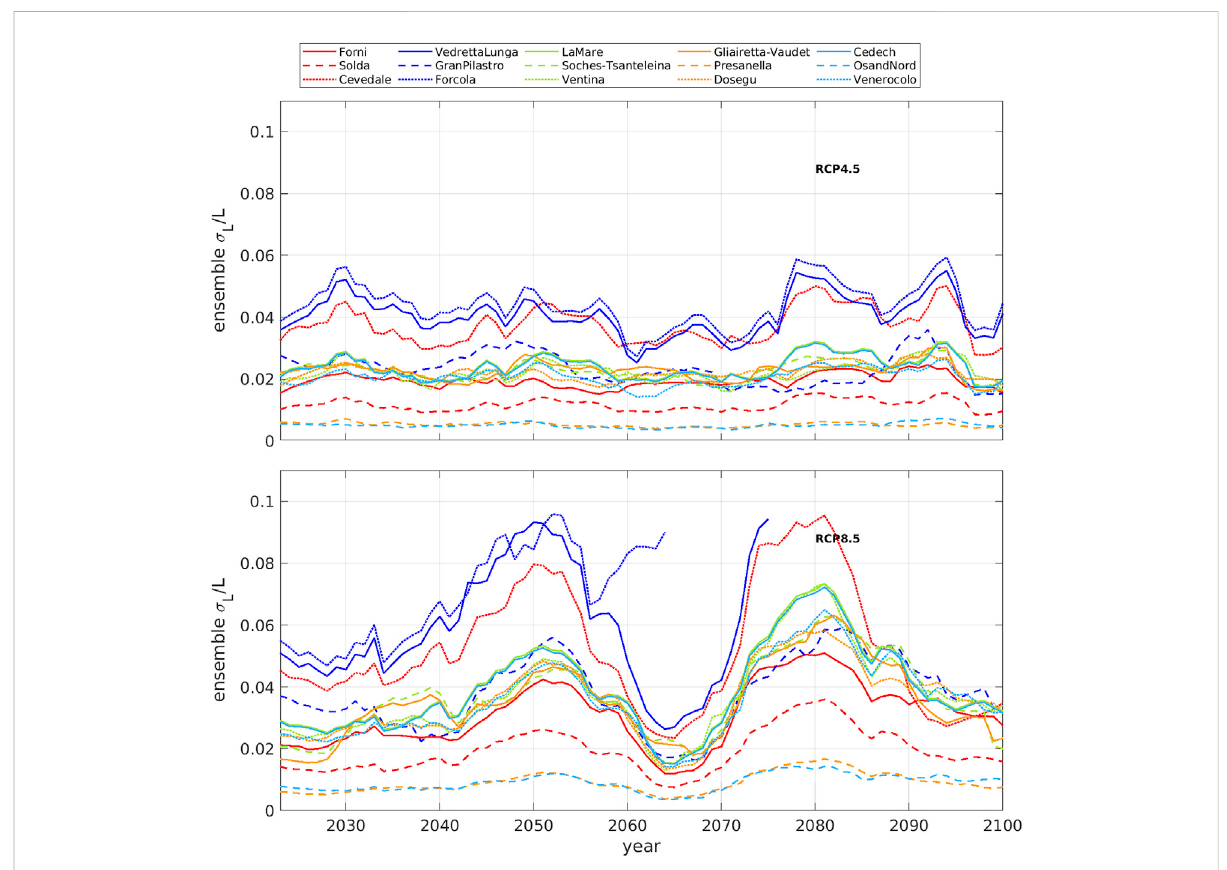
FIGURE 5 Ensemble values of σ L / ~ L derived from climatological projections from 2023 to 2100. Top panel: RCP4.5 scenario. Bottom panel: RCP8.5 scenario. The colours are sorted from the longest (red) to the shortest (light blue)